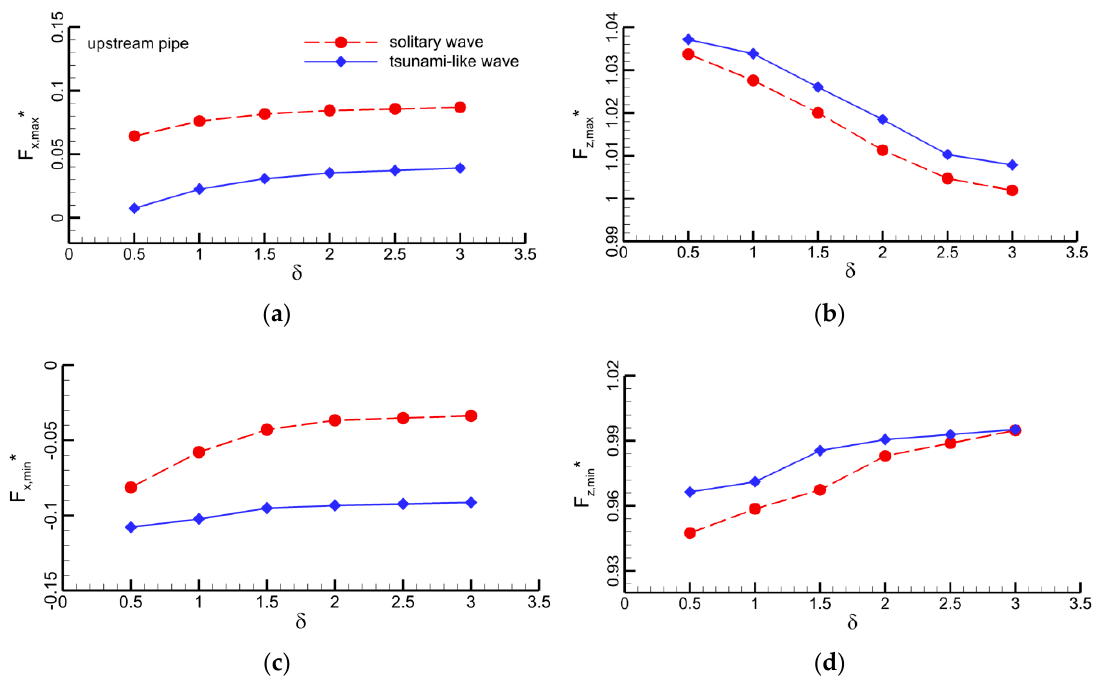
Figure 31. Horizontal and vertical forces on the upstream pipeline as function of spacing ratio; ( a ) maximum horizontal force F x,max *; ( b ) maximum vertical force F z,max *; ( c ) minimum horizontal force F x,min *; ( d ) minimum vertical force F z,min *.